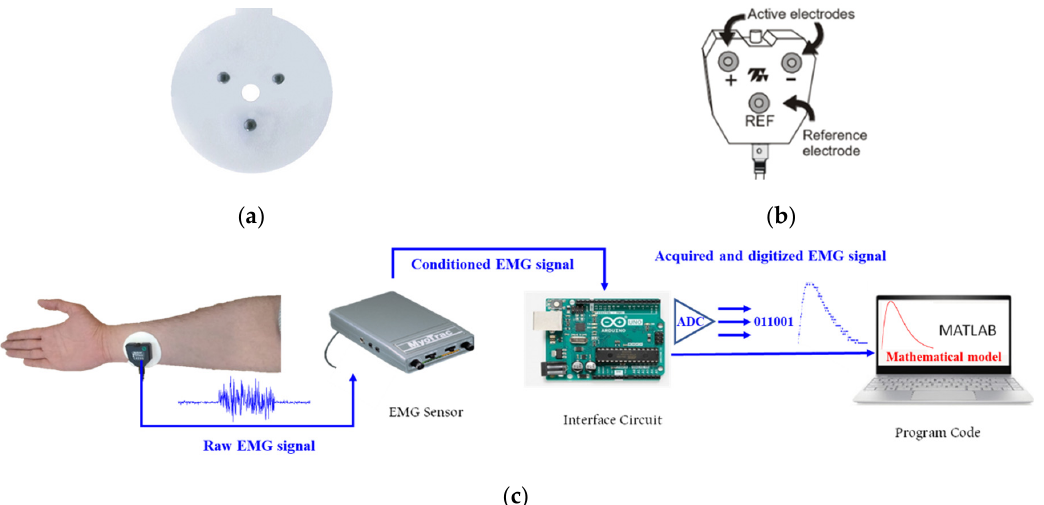
Figure 3. The instrumentation for the EMG signal acquisition: ( a ) sensor probe; ( b ) electrode board; ( c ) probe placement on the forearm and block diagram for transferring EMG signals onto Matlab.